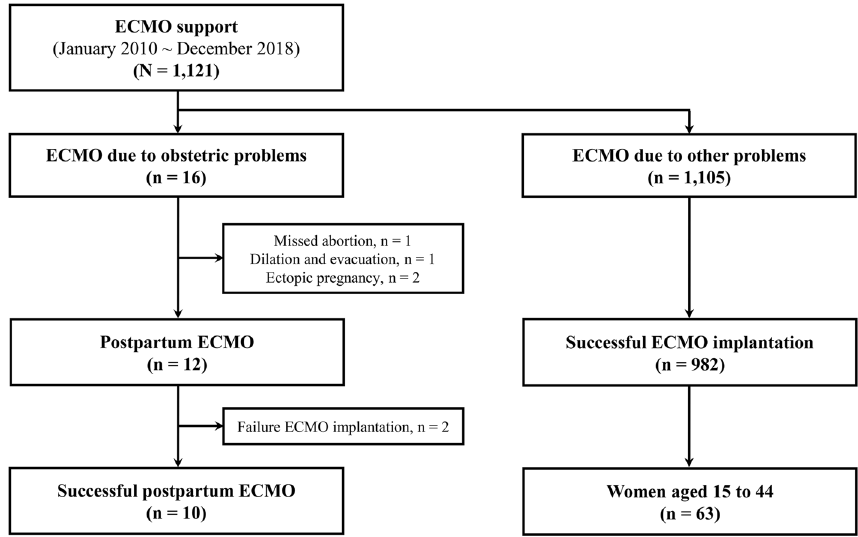
Figure 1. Flowchart of the study. ECMO extracorporeal membrane oxygenation.